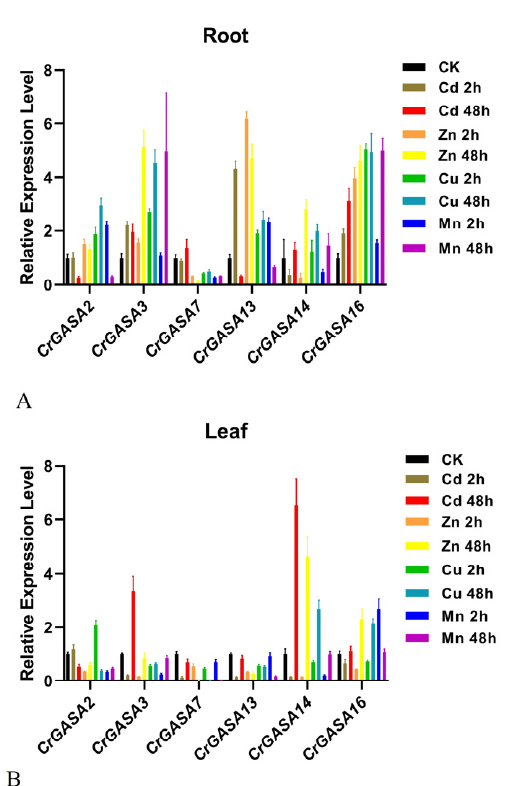
Figure 10. Quantitative RT-PCR detection of the expression levels of the six CrGASA s responding to different heavy metal (HM) stresses (0.1 mM CdCl 2 , 0.5 mM ZnSO 4 , 1 mM MnCl 2 , and 0.1 mM CuSO 4 ) in C. rosea seedlings. ( A ) Root samples under different HM stresses; ( B ) leaf samples under different HM stresses. CK: control. Relative expression values were calculated using the 2 − ∆ Ct method, with the housekeeping gene CrEF-1 α as a reference gene. Bars show the mean values ± SD of n = 3–4 technical replicates.